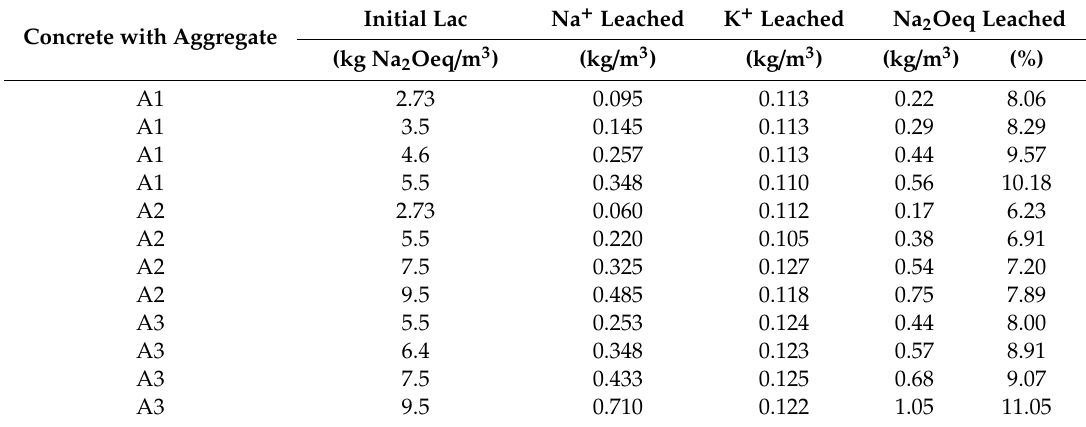
Table 4. Alkali leaching from concrete prisms after one year of testing with the traditional CPT. Initial Lac Na + Concrete with Aggregate